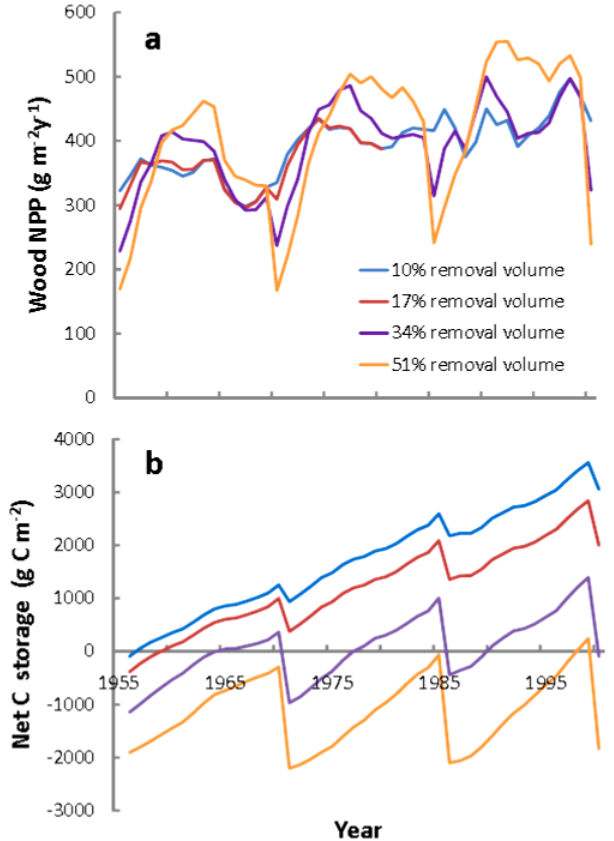
Figure 1. Simulated wood production ( a ) and net C storage ( b ) of a ~100 y old mixed hardwood forest with partial harvests every 15 years at varied intensities: 10% removal (blue), 17% removal (red), 34% removal (purple), and 51% removal